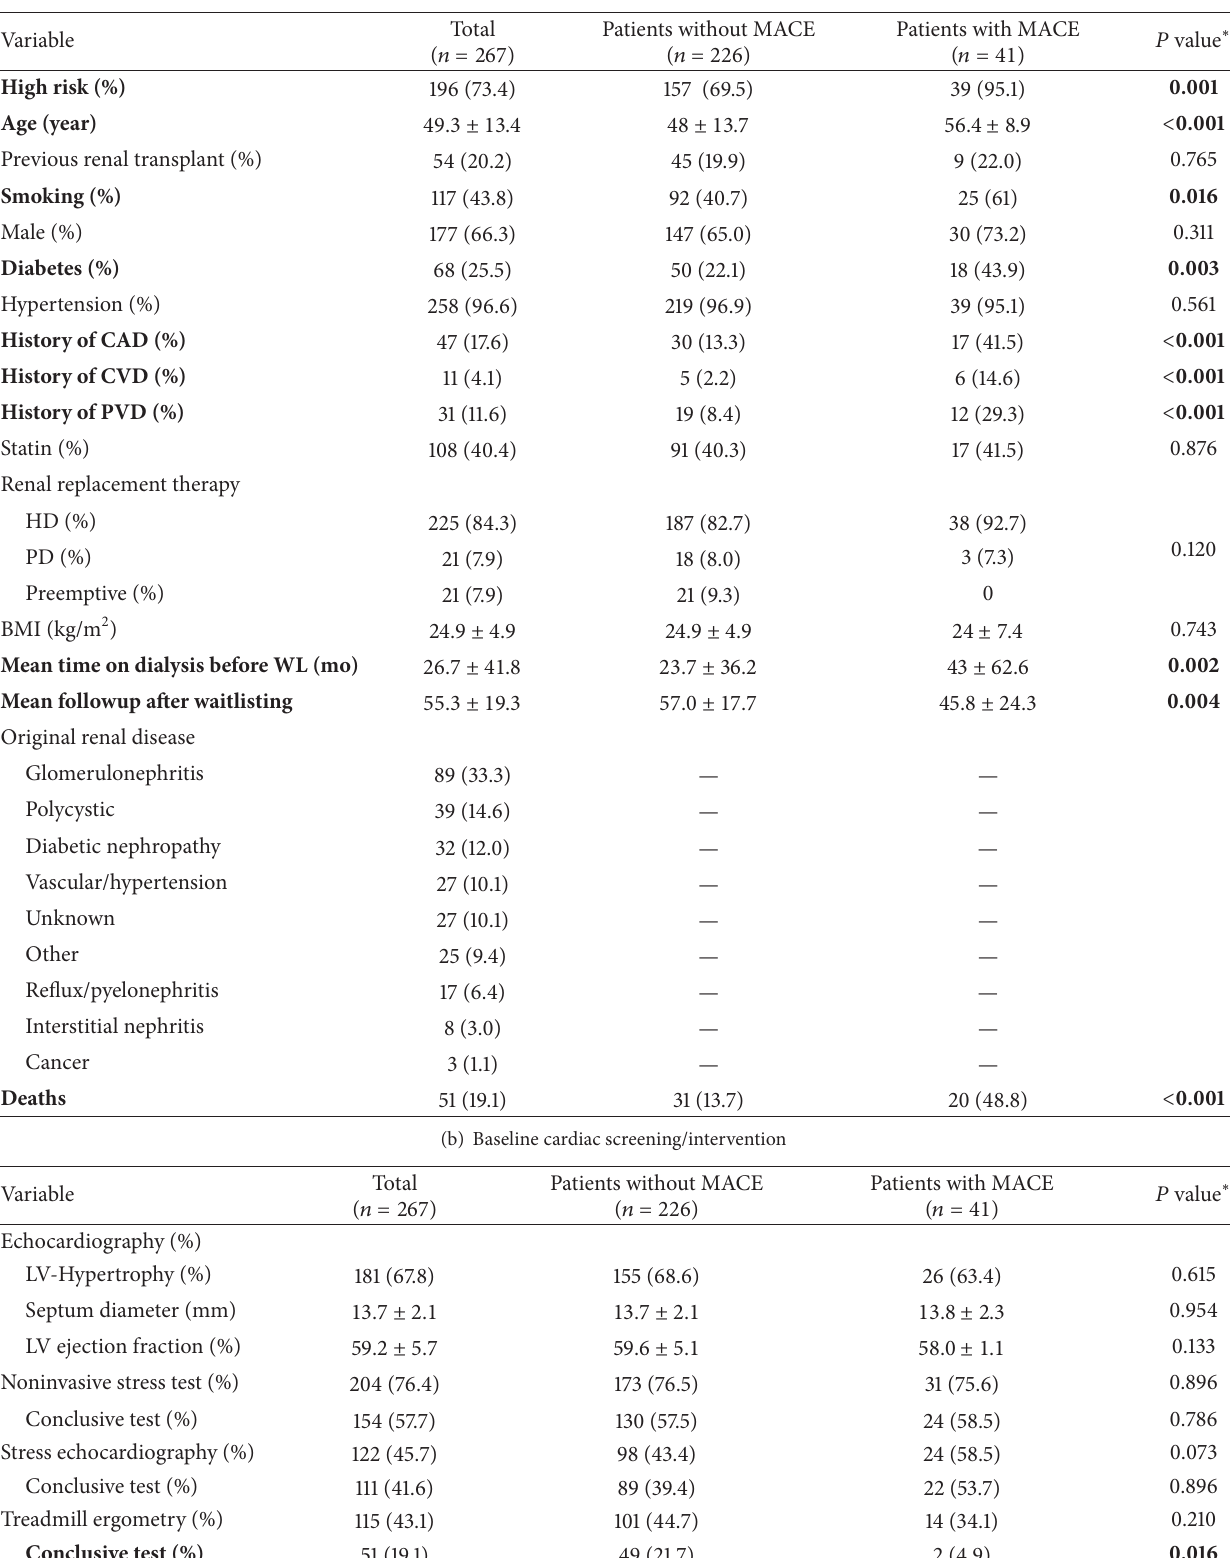
Table 1: Baseline characteristics and cardiac screening/intervention of renal transplant candidates with and without MACE (major adverse cardiovascular events) during